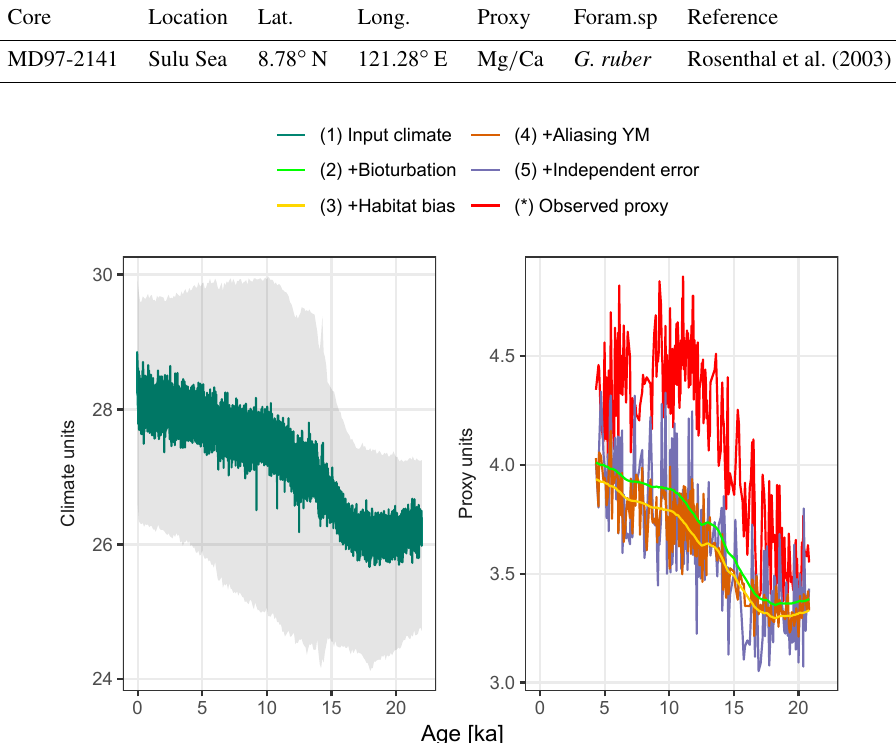
Table 2. Details for sediment core MD97-2141.